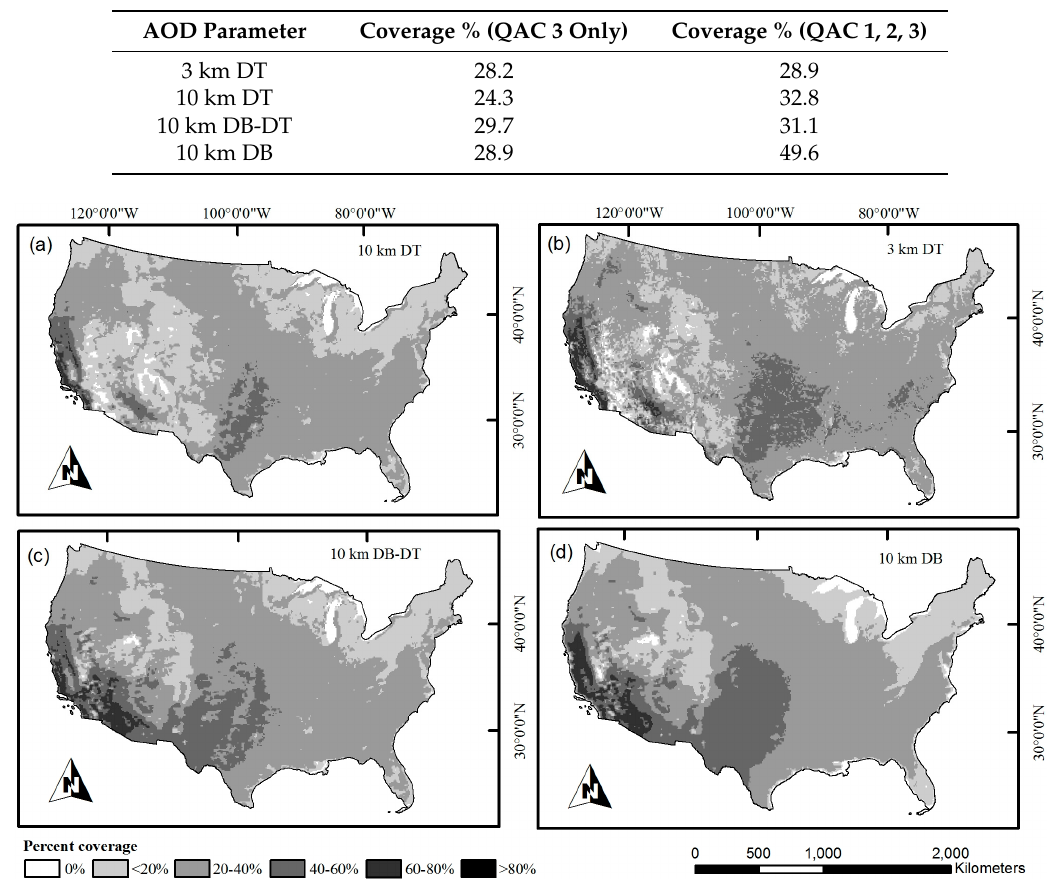
Table 1. Coverage statistics for both QAC 3 retrievals only, and for all AOD retrievals. Coverage is calculated as the percentage of days with a valid Aqua retrieval for each AOD parameter.